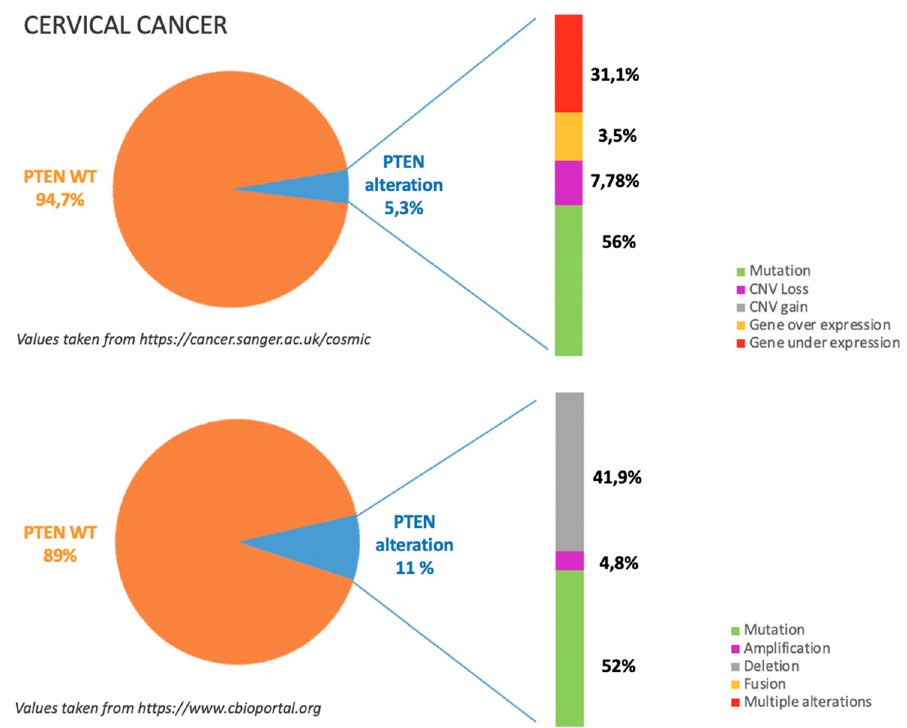
Figure 4. The incidence and type of PTEN alterations according to COSMIC and TGCA datasets in cervical cancer.